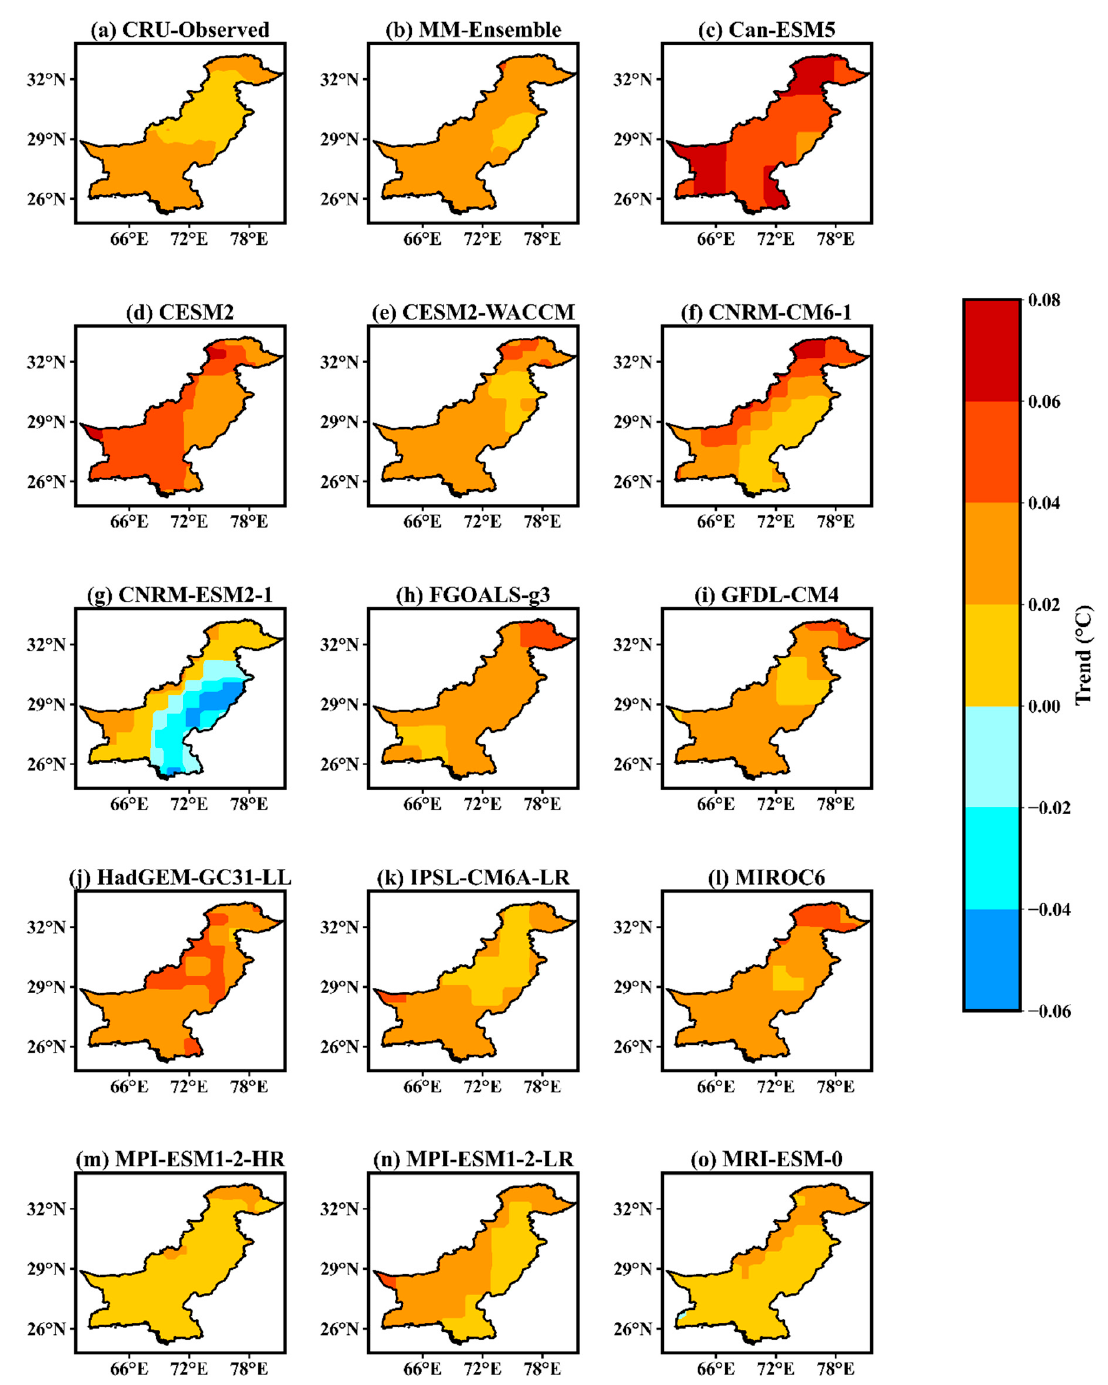
Figure 8. Same as Figure 7, but for DJF season.